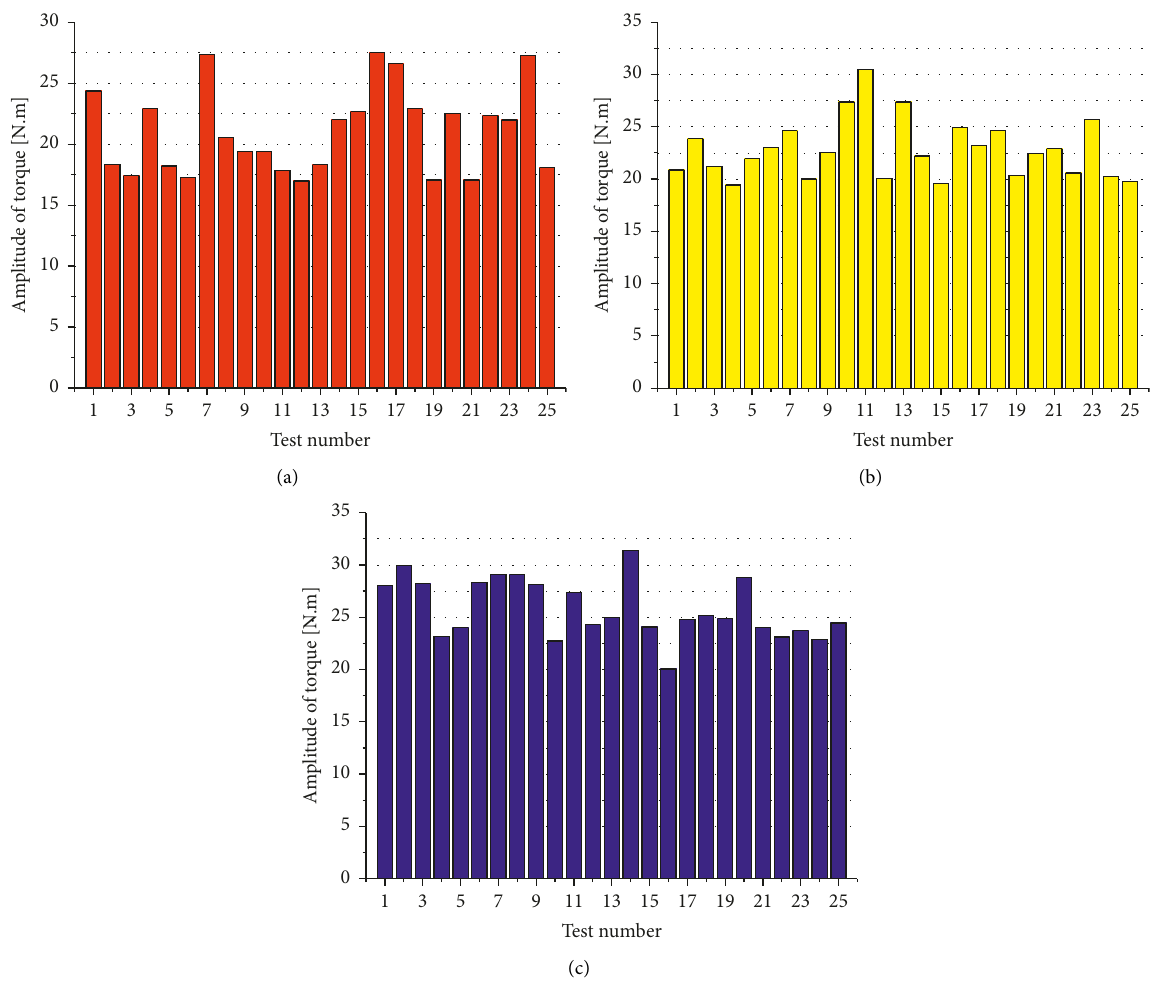
Figure 13: Torque response amplitudes for repeated experiments (a) N (c) N E � 50%, N R � 90%, t 1 �